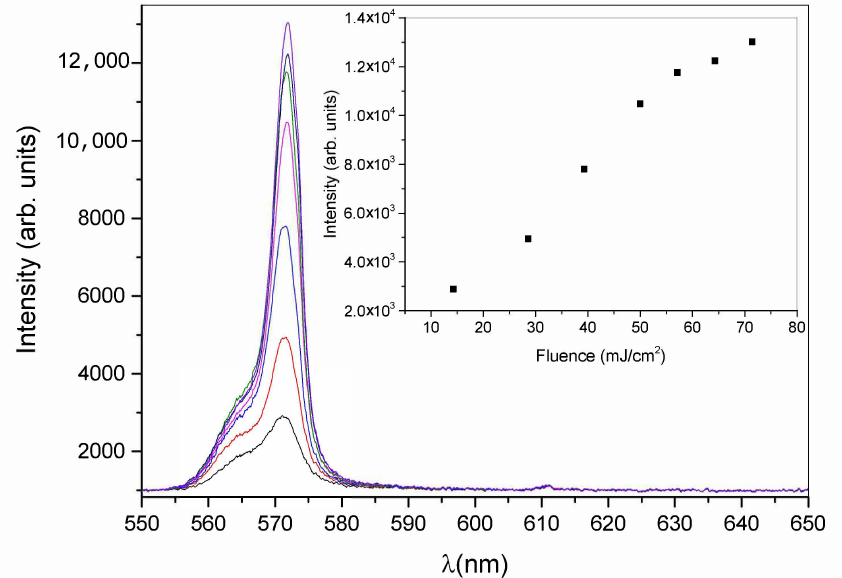
Figure 4. The ASE effect is observed by pumping the free-standing film at λ = 532 nm and τ = 4 ns outside the grating area. In the inset the fluence values used to pump the free-standing